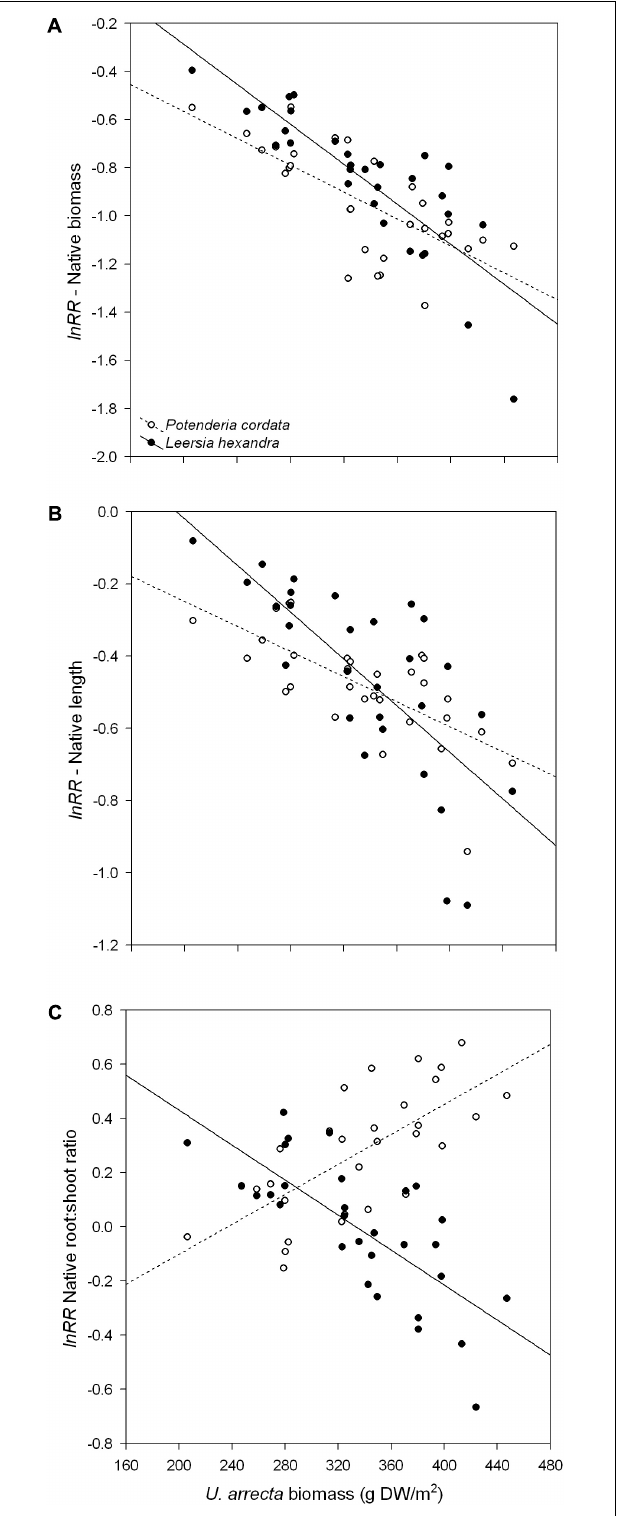
FIGURE 1 | Relationship between the shoot biomass of U. arrecta and different traits of two species of native macrophytes. Shown are the results for (A) total biomass, (B) length, and (C) root:shoot